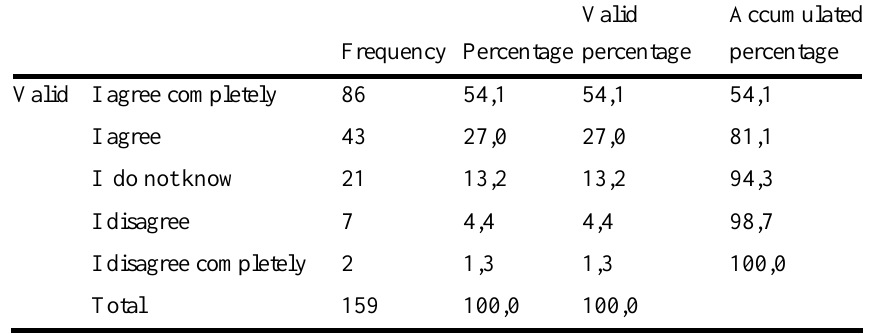
Valid percentage questionnaires´ results, question 6 “Students feel satisfaction when the teacher uses the lingua